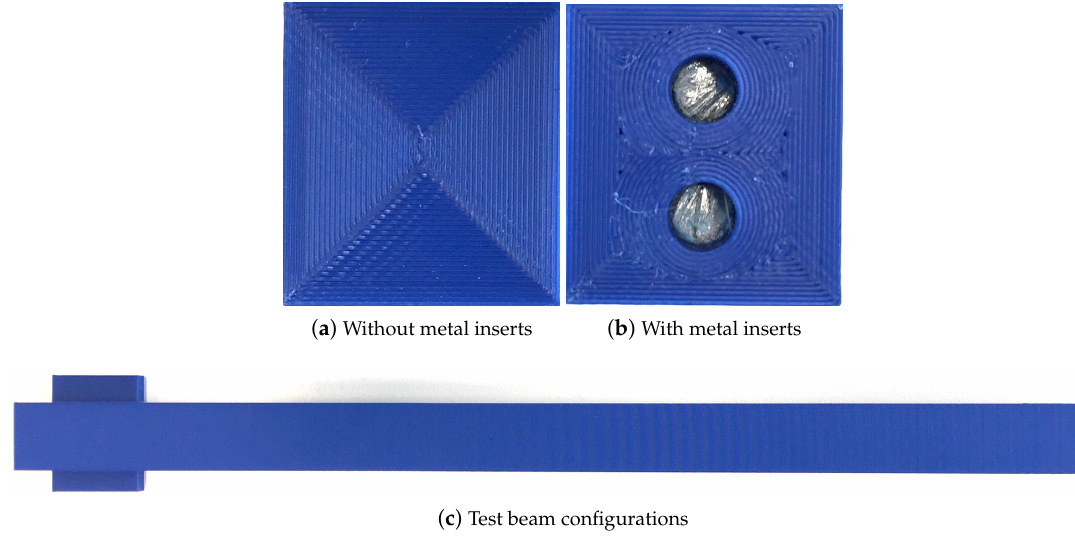
Figure 10. Investigation of the stiffness of a test beam with and without metal